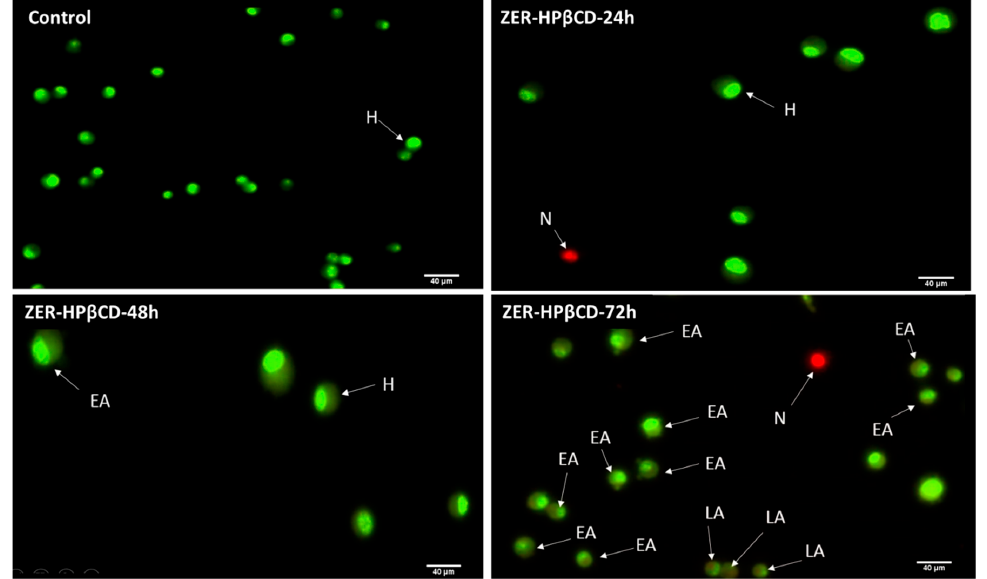
Figure 6. AO/PI assay for MCF-7 cells treated with the co-administration of ZER-HP β CD and TP5-iRGD peptide at three different time points of 24, 48 and 72h. H: healthy, EA: early apoptosis, LA: late apoptosis, N: necrosis.